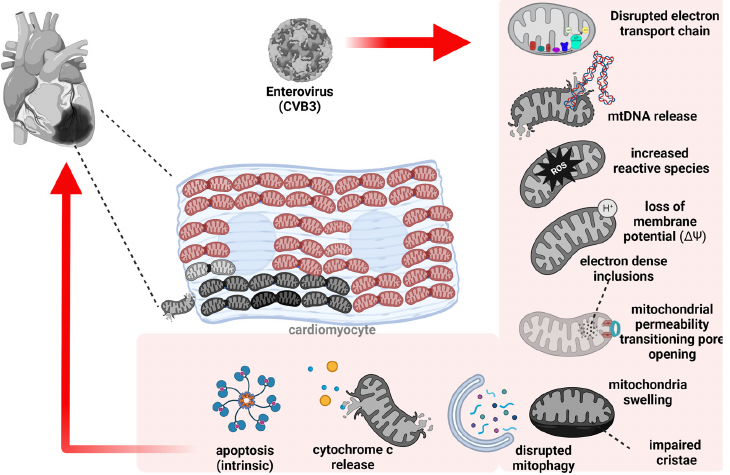
Figure 1. Schematic depiction of virus-induced mitochondrial injury during viral myocarditis. Car- diotropic viruses such as CVB3/EVs, coronaviruses, parvovirus, influenza A virus, Hep C virus, and reovirus can directly injure mitochondria and induce cardiomyocyte pathogenesis. Virus-induced mitochondrial injury includes: disruption of the electron transport chain, release of mtDNA, in- creased ROS production, loss of membrane potential ( ΔΨ ), increased electron dense inclusions, mi- tochondrial permeability transition pore opening, mitochondrial swelling, impaired cristae, dis- rupted mitophagy, cytochrome c release, and mitochondria-mediated intrinsic apoptosis.